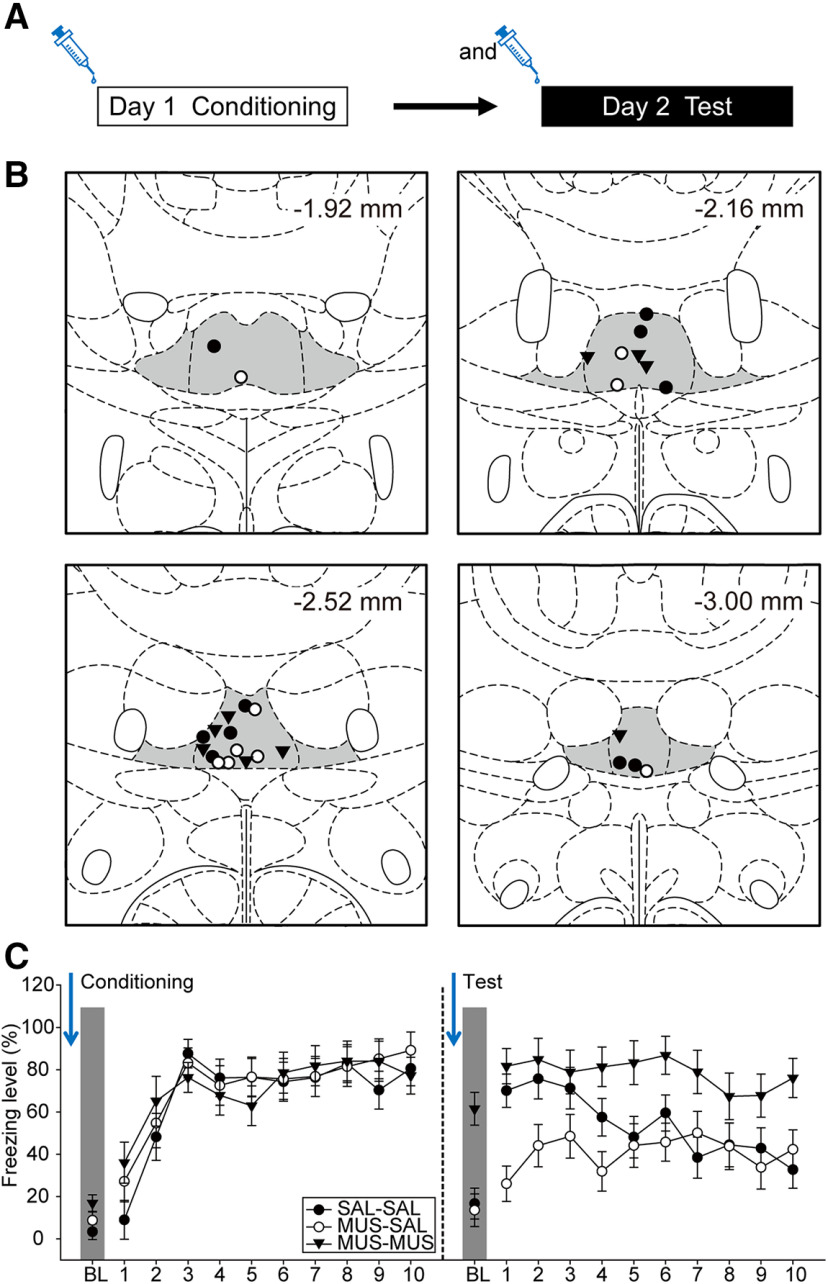
Retrieval of trace fear acquired under ReRh inactivation reprised under ReRh inactivation. A, Experimental design. Animals underwent a 2-d behavioral experiment, in which the animals received drug infusion immediately before both conditioning and retrieval test. B, Injector tip placements of all the animals included in data analyses at levels −1.92, −2.16, −2.52, and −3.00 mm posterior relative to bregma. The gray areas marked in the atlas are the Re and ventral Re. C, The freezing behavior of SAL-SAL (n = 10), MUS-SAL (n = 9), and MUS-MUS groups (n = 9) when the injections were performed before both conditioning and retrieval test.